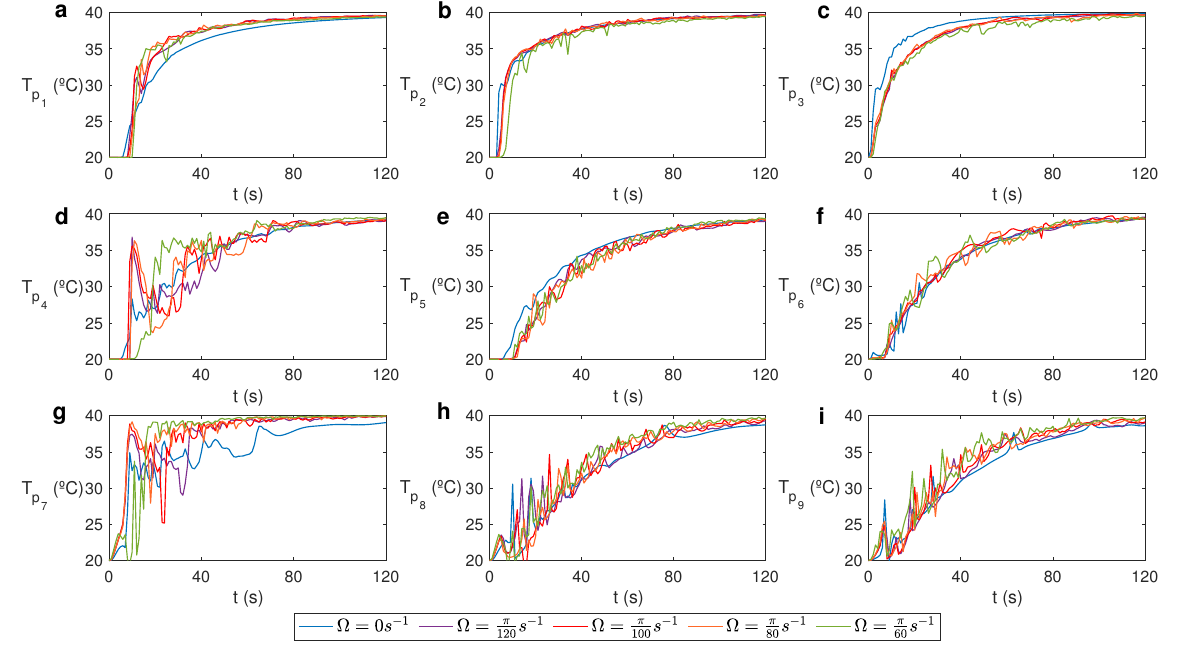
Figure 7. Time evolution of the temperature T in the monitored points of Figure 1b for T e = 40 ◦ C for different values of the rotation rate Ω . ( a ) Temperature profiles for point p 1 ; ( b ) Temperature profiles for point p 2 ; ( c ) Temperature profiles for point p 3 ; ( d ) Temperature profiles for point p 4 ; ( e ) Temperature profiles for point p 5 ; ( f ) Temperature profiles for point p 6 ; ( g ) Temperature profiles for point p 7 ; ( h ) Temperature profiles for point p 8 ; ( i ) Temperature profiles for point p 9